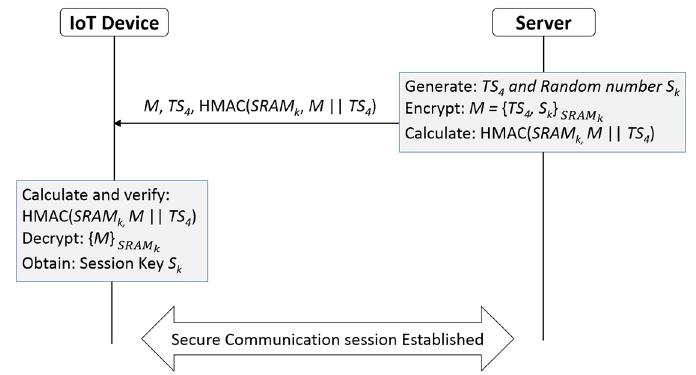
Figure 5. Establishment a secure session key.